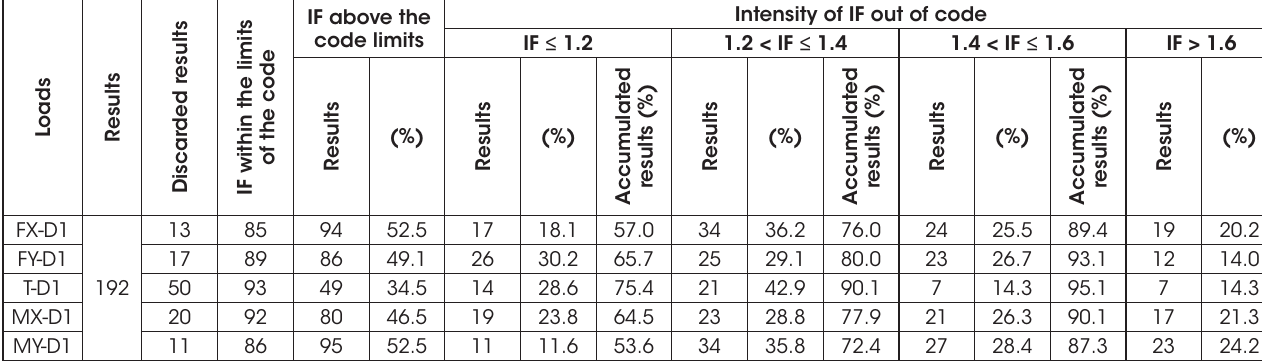
Results for distance